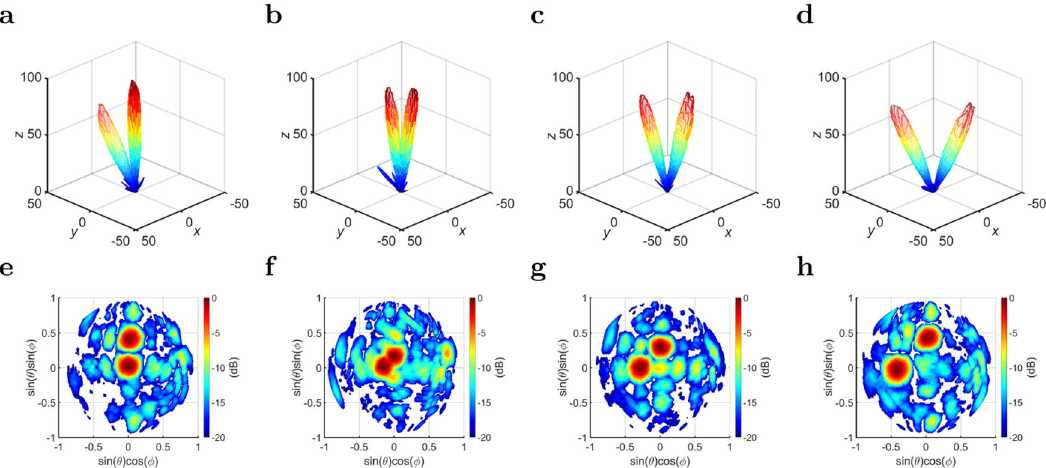
Fig. 7 Multiple-beam measurement. The normalized measured radiation patterns for various values of ( ψ ), when both sides A and B of the 7×7 PEX array are excited simultaneously: a – d The measured far- fi eld 3D gain patterns for the cases: a ψ = 0° and 285°, b ψ = − 5° and 275°, c ψ = − 10° and 280°, and d ψ = − 15° and 285°, plotted in linear scale (V/m) and normalized to an arbitrary value of 100. e – h The measured far- fi eld U-V gain patterns for the cases: e ψ = 0° and 285°, f ψ = − 5° and 275°, g ψ = − 10° and 280°, and h ψ = − 15° and 285°, plotted in dB scale. All the beams can be independently scanned, and a multitude of radiation directions are achieved. More measured results are presented in Supplementary Note